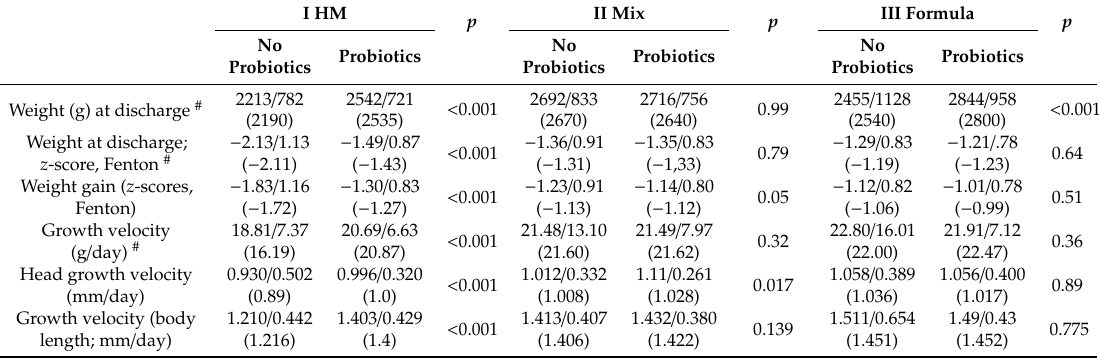
Table 6. Growth parameters of the GNN cohort stratified to type of milk feeding and treatment with